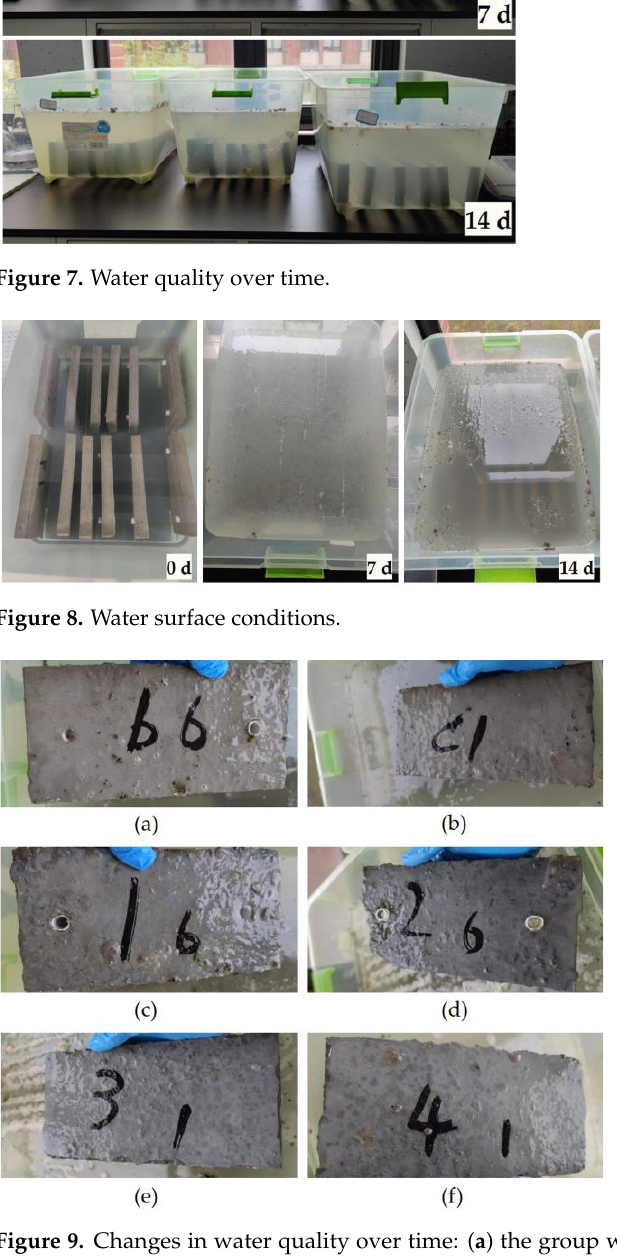
Figure 9. Changes in water quality over time: ( a ) the group with no addition; ( b ) the group with coating; ( c ) the group with 0.05% addition; ( d ) the group with 0.10% addition; ( e ) the group with 0.15% addition; ( f ) the group with 0.20% addition.